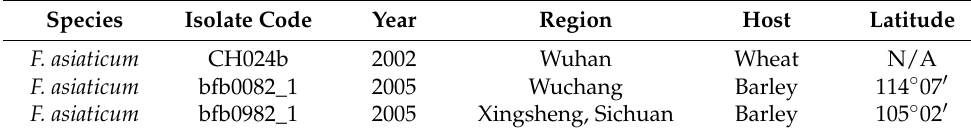
Table 1. Information about F. asiaticum strains included in this